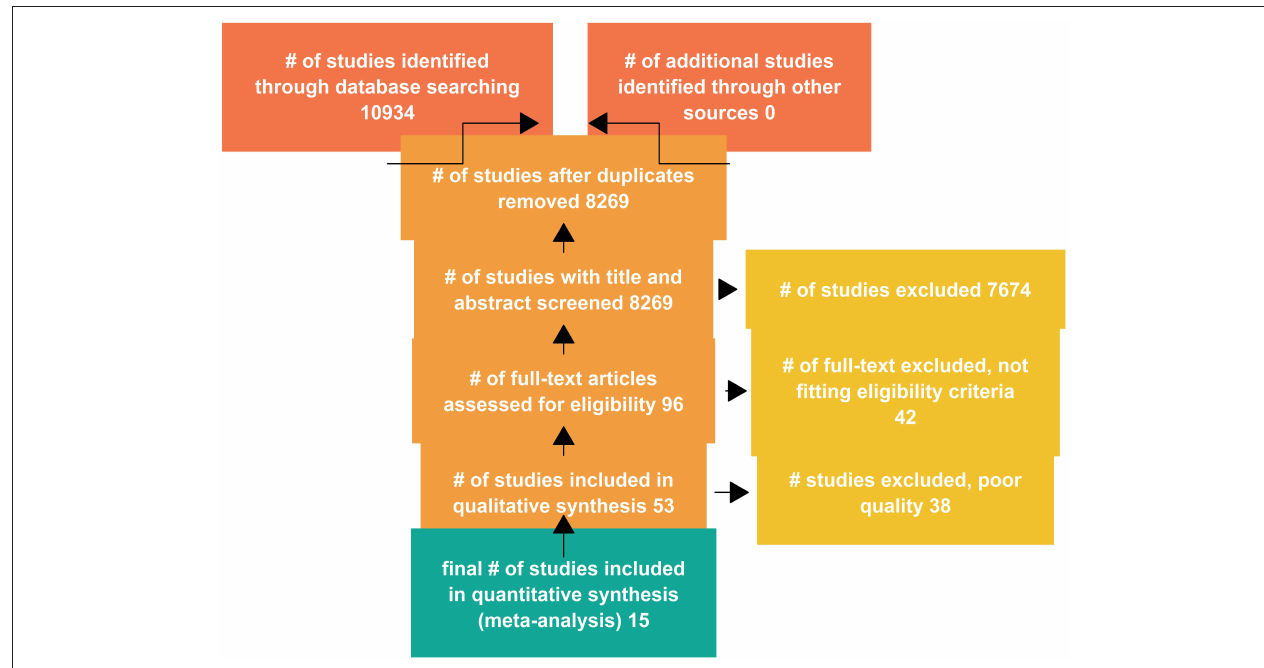
FIGURE 2 | Results of the search